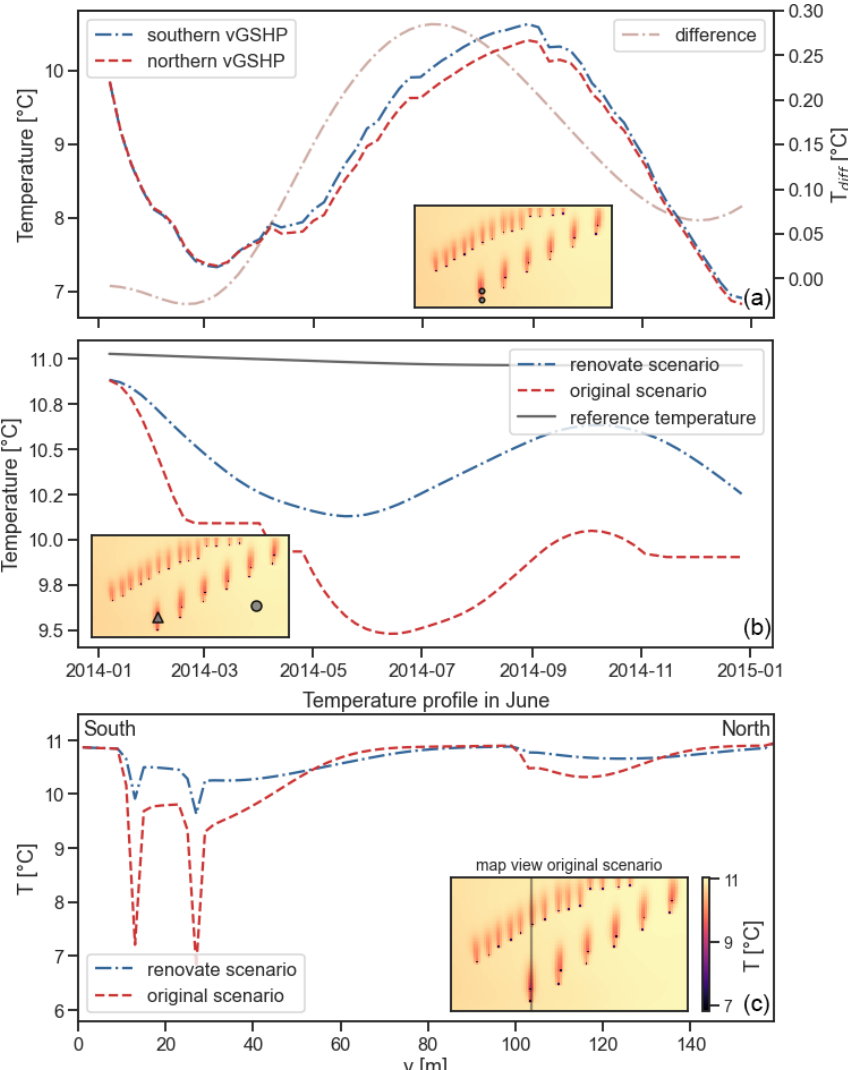
Figure 5. (a) Time series for one year of two vGSHP in the southern part of the model. The influence of the southern vGSHP (blue) is expressed as a reduced temperature in the northern vGSHP (red). The difference between the two vGSHP is plotted and reaches its maximum around end of June. (b) Time series of temperature at 50m depth over the same time period at a location (triangle) affected by the thermal plumes of the two vGSHPs marked in A. The time series are plotted for the original (red) and renovated (blue) scenario. A reference temperature at the same depth at a location (marked by the circle) unaffected by thermal plumes is plotted in gray. (c) North-south trending temperature profile at day 180 at a depth of 50m below surface. Pronounced peaks are temperatures within the vGSHPs. Between the peaks, temperatures are lower than the undisturbed temperature of 11 ◦ C. The black line in the temperature field on the right shows the position of the temperature